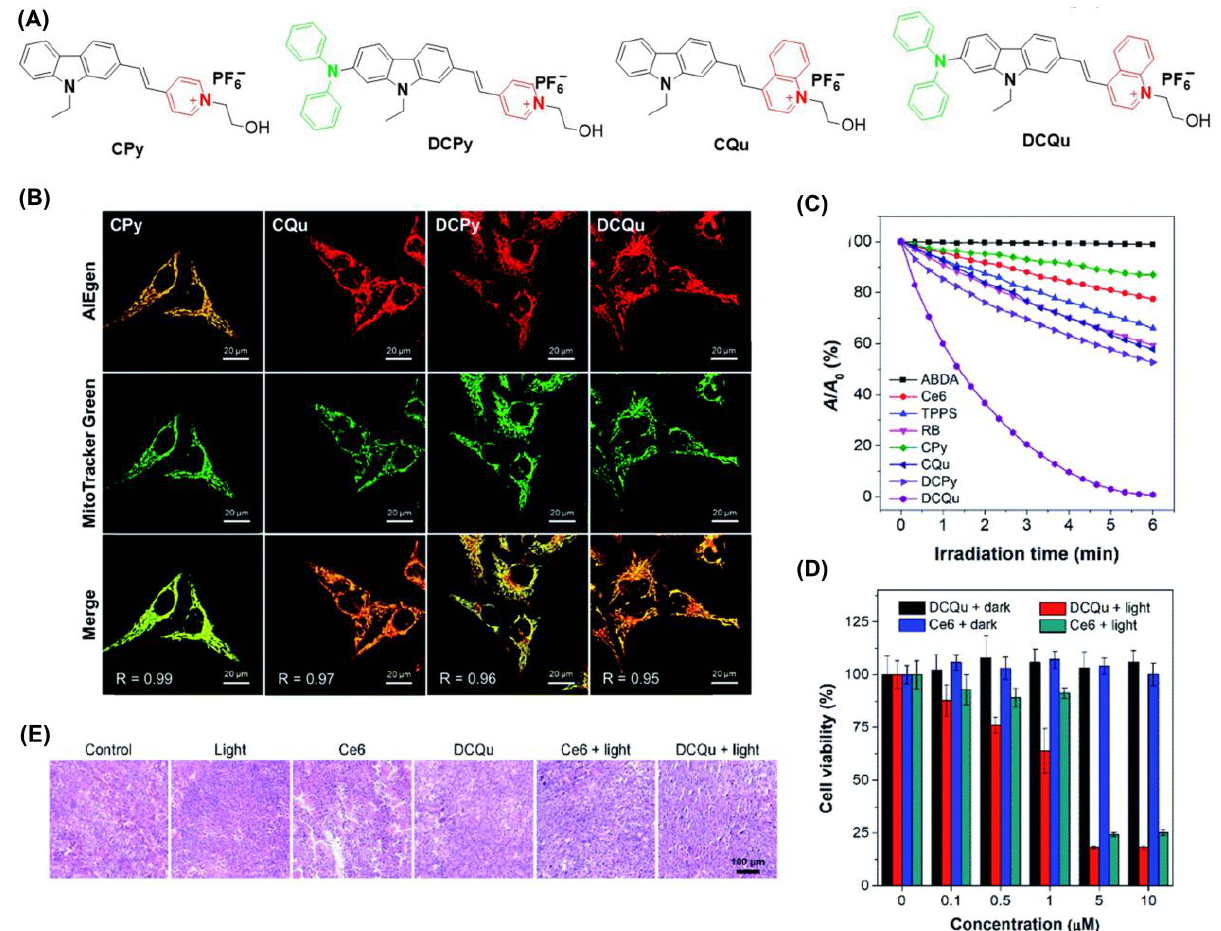
Figure 8. ( A ) Structure of CPy, CQu, DCPy and DCQu; ( B ) CLSM images of HeLa cells stained with CPy, CQu, DCPy and DCQu and various probes; ( C ) detection of 1 O 2 through ABDA; ( D ) cell viability of HeLa cancer cells stained with DCQu; ( E ) H&E staining analysis of tumor tissues treated with DCQu. Reprinted with permission from Ref. [75]. Copyright 2020 Royal Society of Chemistry.